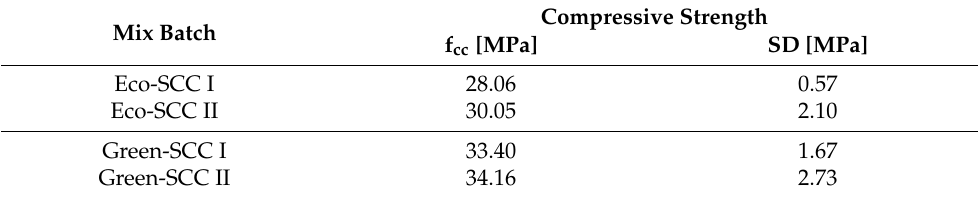
Table 3. Results of compressive strength